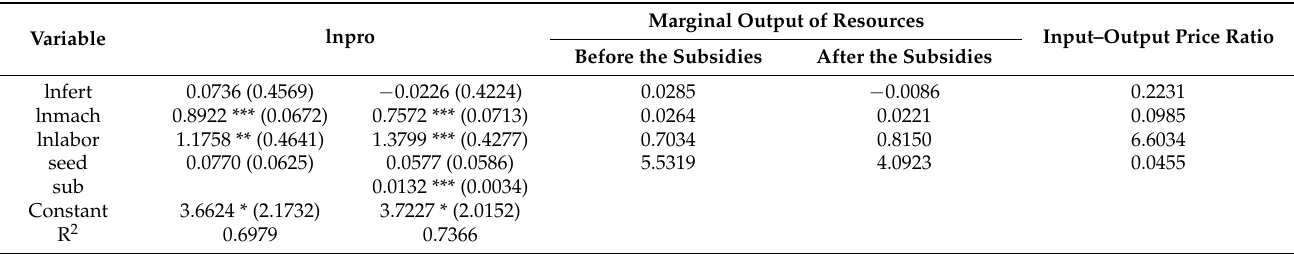
Table 3. Empirical results of the resource allocation effect of cotton subsidies in 12 provinces in China from 2011 to